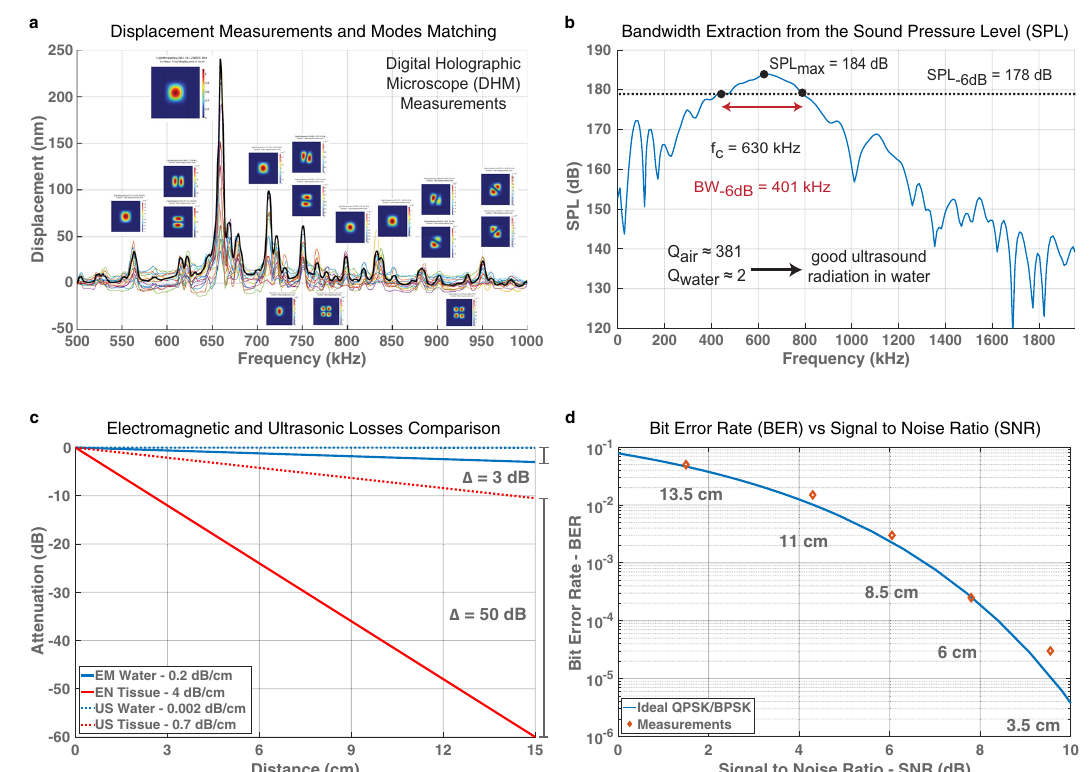
Fig. 2 Testing. a Peak displacement measurement of the LN pMUT device with a Digital Holographic Microscope (DHM) and modes matching in COMSOL Multiphysics. b Fourier transform of the received signal by the pMUT. This shows a bandwidth of BW − 6dB ≈ 401 kHz and center frequency of ≈ 630 kHz (this is lower than the one in air due to the damping effect of the water). The low Q water ≈ 2 indicates that most of the energy is radiated, f water making the LN pMUT a good ultrasonic transmitter and receiver. This bandwidth is higher than pMUTs based on other piezoelectric materials such as AlN and ScAlN-36% as shown in Fig. 8c – e. c Attenuation of electromagnetic (EM) and ultrasonic (US) waves when considering both water and tissue phantom as propagation medium 18 – 20 . The implantation range considered is from 0 to 15 cm. In water, the EM waves have 3 dB more attenuation than US waves at 15 cm. However, this difference dramatically increases in tissue going up to 50 dB, making the US waves the ideal choice for intrabody communication. d Theoretical bit error rate (BER) vs Signal-to-Noise Ratio (SNR) plot for a Quadrature Phase Shift Keying (QPSK) communication link, which is the protocol that is going to be used in the real image transmission. The plot also presents measured BERs at several implantation distances that are going the be used in the intrabody setup. Some discrepancies are due to the misalignment of the transducers and implantation distance error, which can lead to lower SPL as shown in Fig.